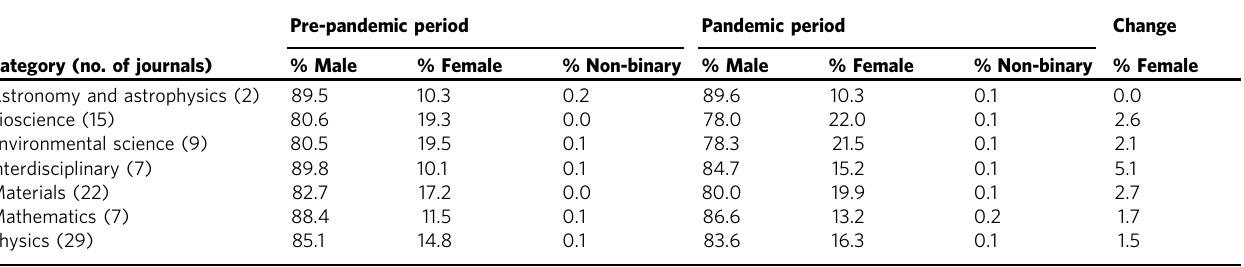
Table 3 Percent of corresponding authorship by gender for pre-pandemic and pandemic periods, by journal